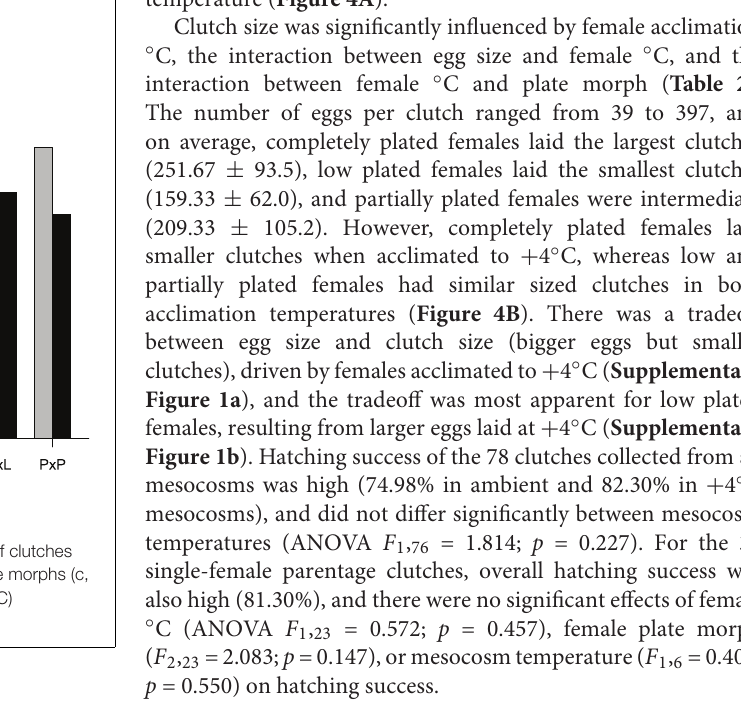
higher success at + 4 ◦ C when paired with completely plated females, lower success at + 4 ◦ C when paired with partially plated females, and no difference in siring success between mesocosm temperatures when paired with low plated females (interaction: Meso x male plate P, Table 1 and Figure 3